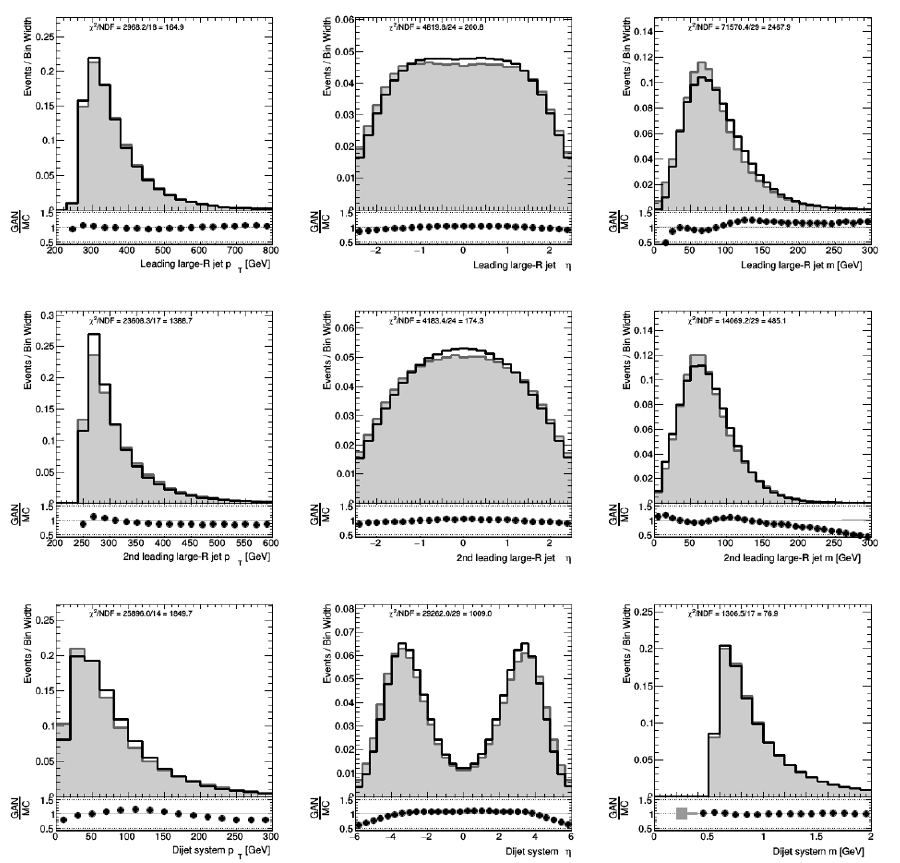
Figure 5 . Comparison of kinematic observables with respect to reco-level ( MadGraph5 + Pythia8 + Delphes3 ) Monte Carlo simulation. The gray area represents the MC prediction, and the black line indicates the GAN output.